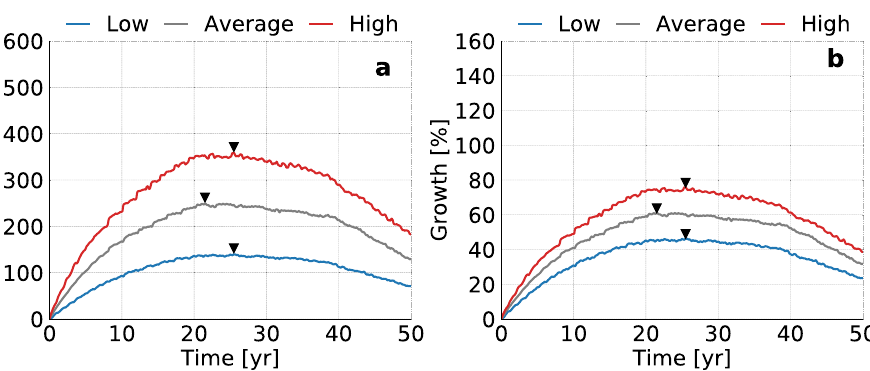
Figure 6. Simulated growth of fresh groundwater for low (blue line), average (dark grey line), and high (red line) estimates of the global specific yield in sandy shores, where the black triangles point to the time with the maximum growth of fresh groundwater. The graphs represent the change in volume (left) and percentage (right) with respect to the initial conditions (i.e. equal to equilibrium state without beach